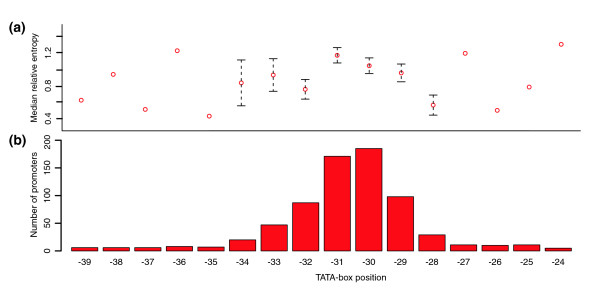
The spacing between TATA box and the dominant TSS is associated with transcriptional specificity. (a) Tissue specificity (measured as median relative entropy) for promoters with different TATA-TSS spacing. Positions with 20 counts or more are shown as red dots with standard error bars. (b) Histogram showing number of promoters with the TATA box located at a given position. In both plots, only the most prominent TATA box is considered in each promoter. Both representations indicate that most functional TATA boxes reside in a narrow 4 bp window from positions -32 to -29, dominated by positions -31 and -30. The rapid decrease in site counts and transcriptional specificity downstream of -29 suggests that 28 bp is the minimal TATA-TSS distance for TATA-driven initiation; it might also have functional properties distinct from more favorable spacings (see main text). bp, base pair; TSS, transcription start site.